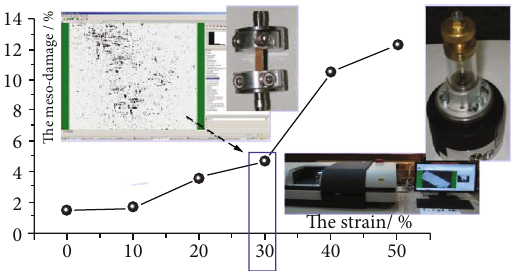
Figure 12: Porosity of soft PSD material varies with